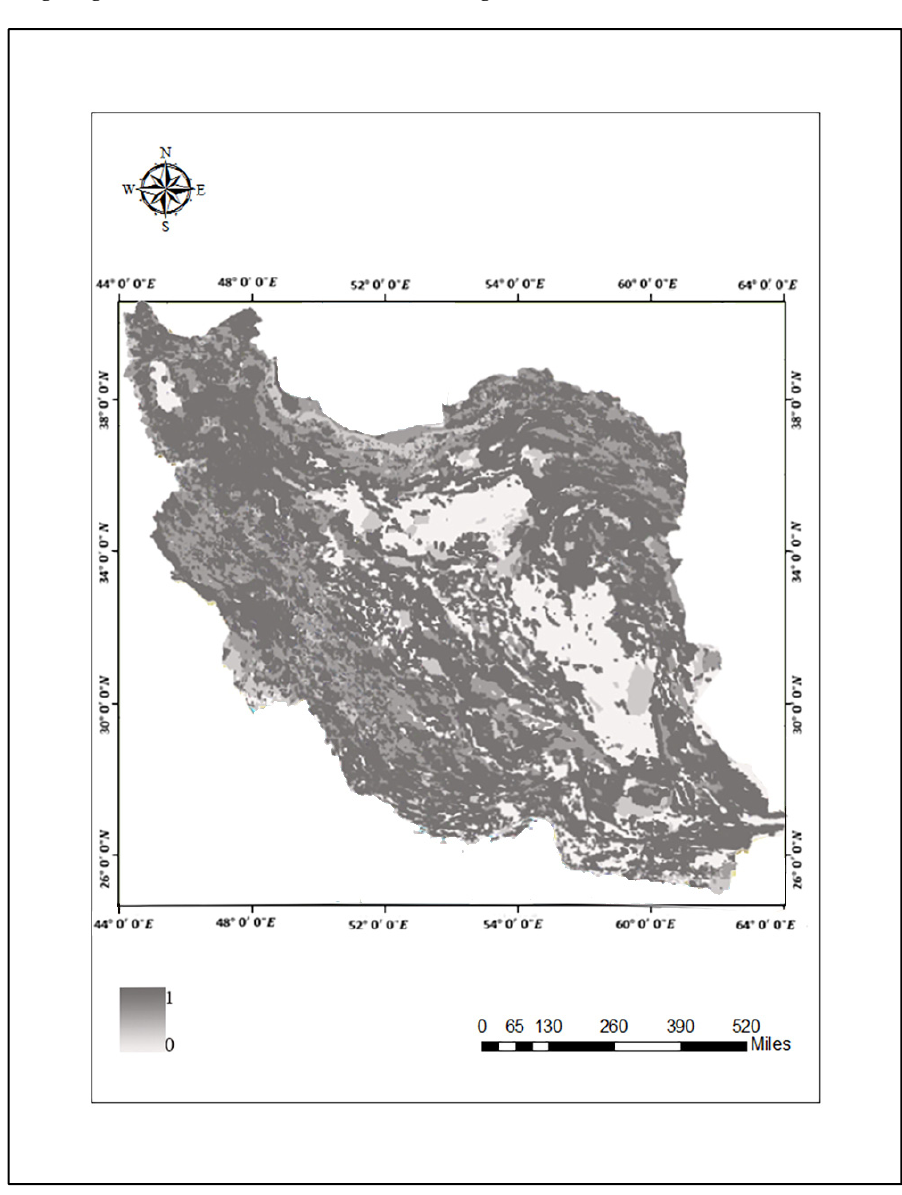
Figure 9. Vulnerability map based on landcover (2016).